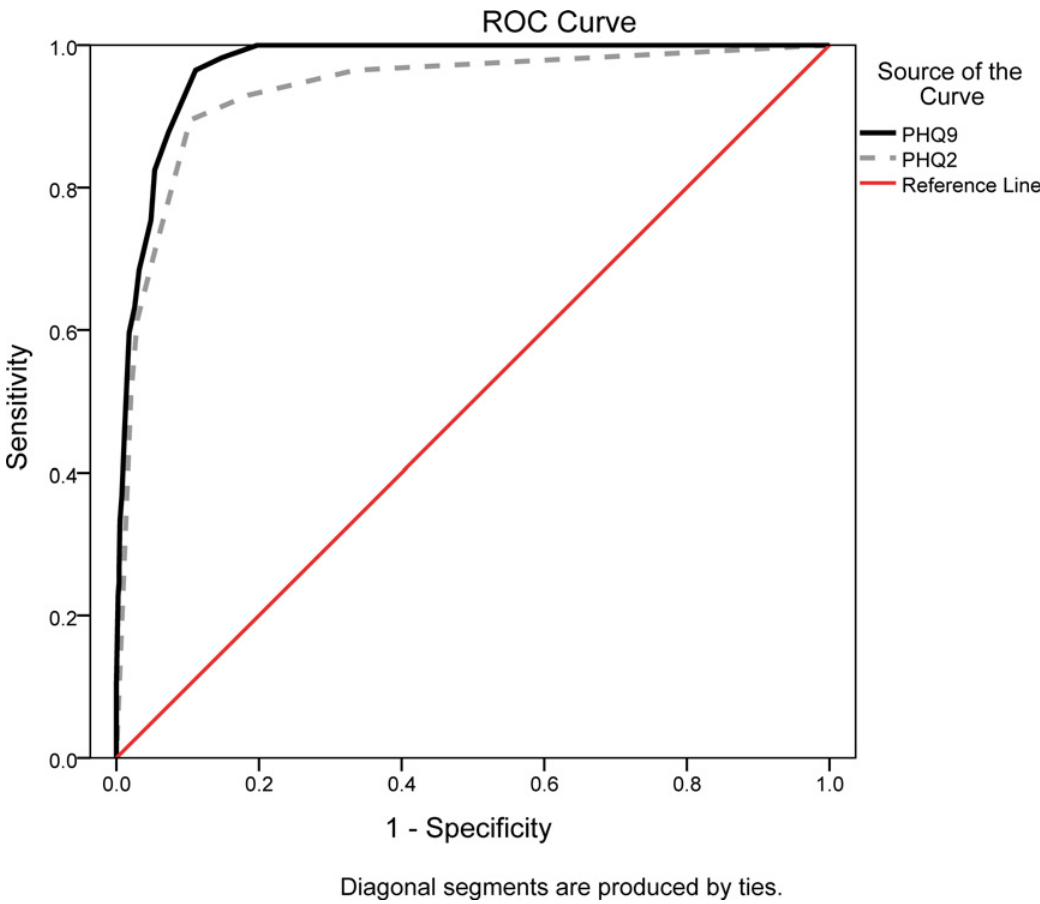
Fig 2. The receiver operating characteristic (ROC) curve of the PHQ-9 and PHQ-2 versus the SCID-I for a depression diagnosis.